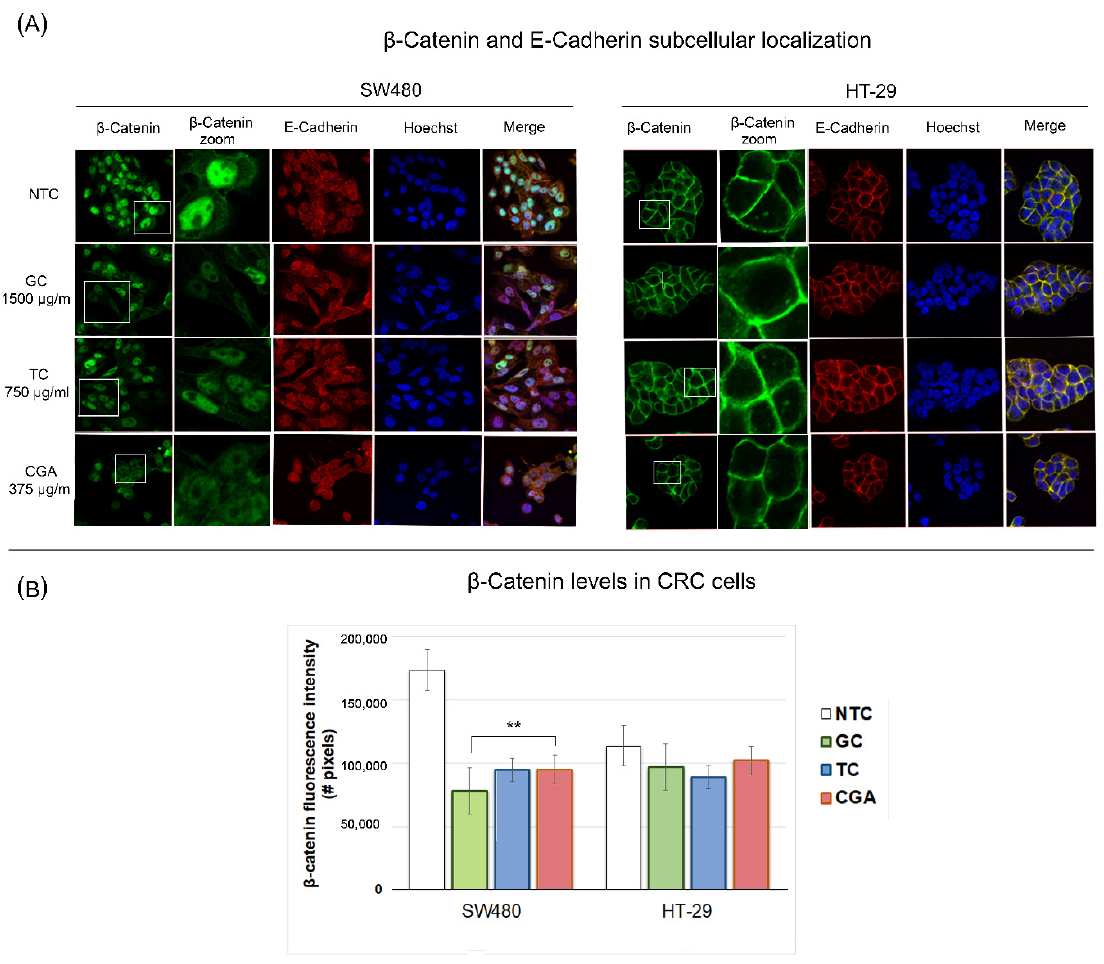
Figure 7. Subcellular localization of β -catenin (green) and E-cadherin (red) proteins in SW480 and HT29 cells treated with chlorogenic acid (CGA), roasted coffee (TC), and green coffee (GC) at 24 h. The panel ( A ) includes representative images, and the ( B ) panel is the β -catenin protein fluorescence intensity in both treated cell lines. The images were captured through an Olympus FV1000 confocal laser scanner microscope with a 60x objective and image scale of 150 µm. Values are expressed as the mean ± SEM of three independent experiments. Two-way ANOVA, difference to non-treated cells, ** p ≤ 0.01; # = number.